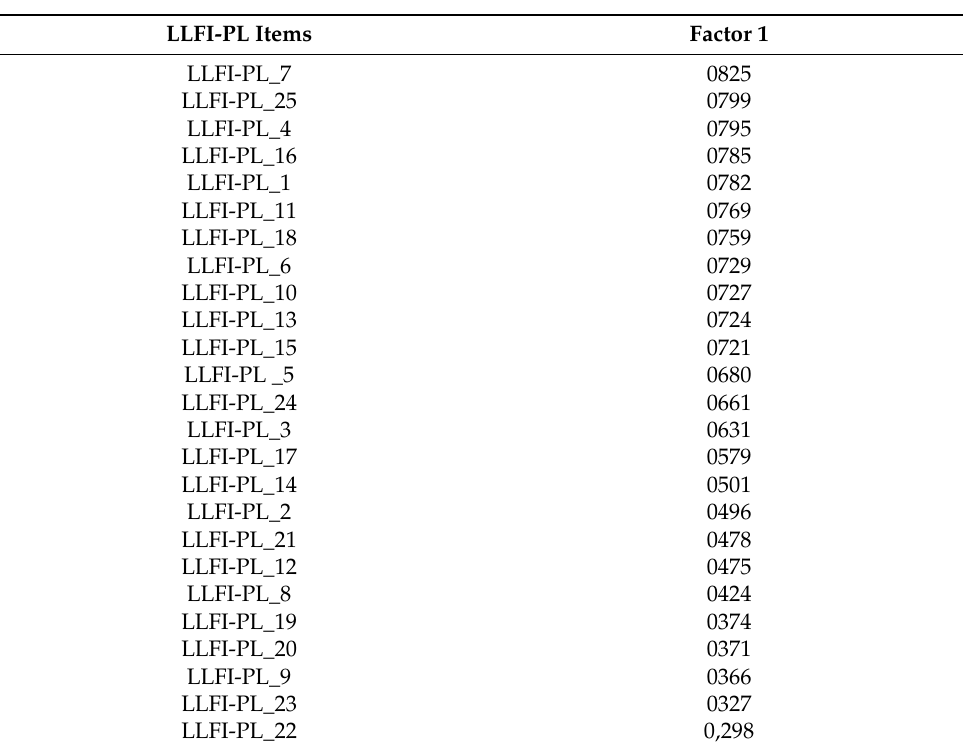
Table 6. Factor loadings of all items for one factor